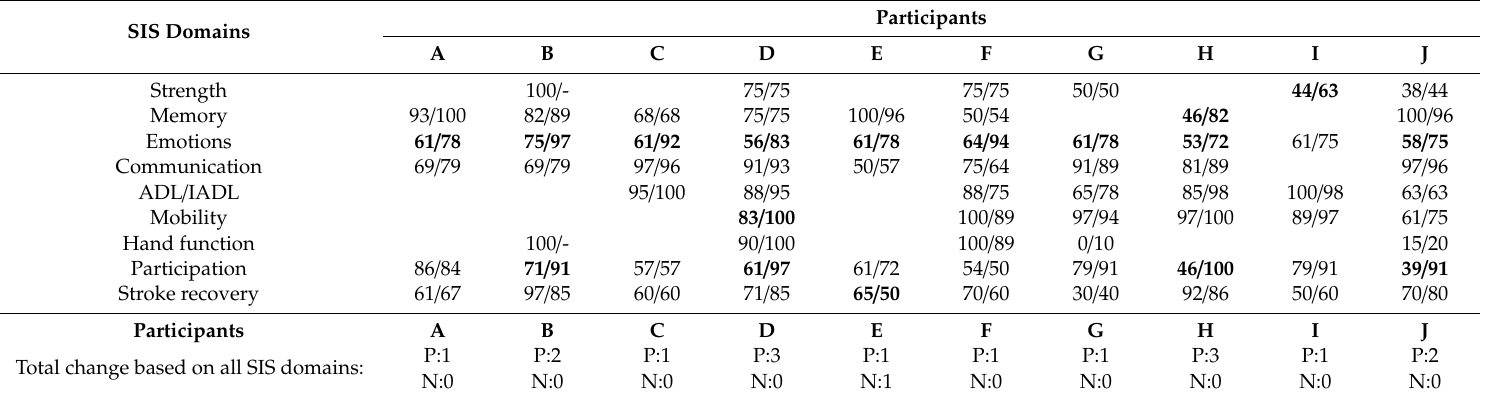
Table 2. Impact of stroke at the baseline and after three months of the work trial in the stroke impact scale 3.0 (SIS) domains, and clinically meaningful changes between these phases ( n = 10).